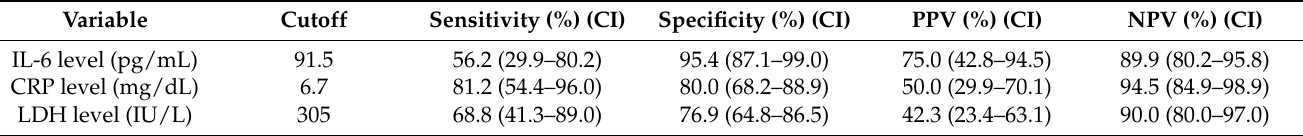
Table 5. The cutoff value of three inflammatory markers with the highest positive predictive